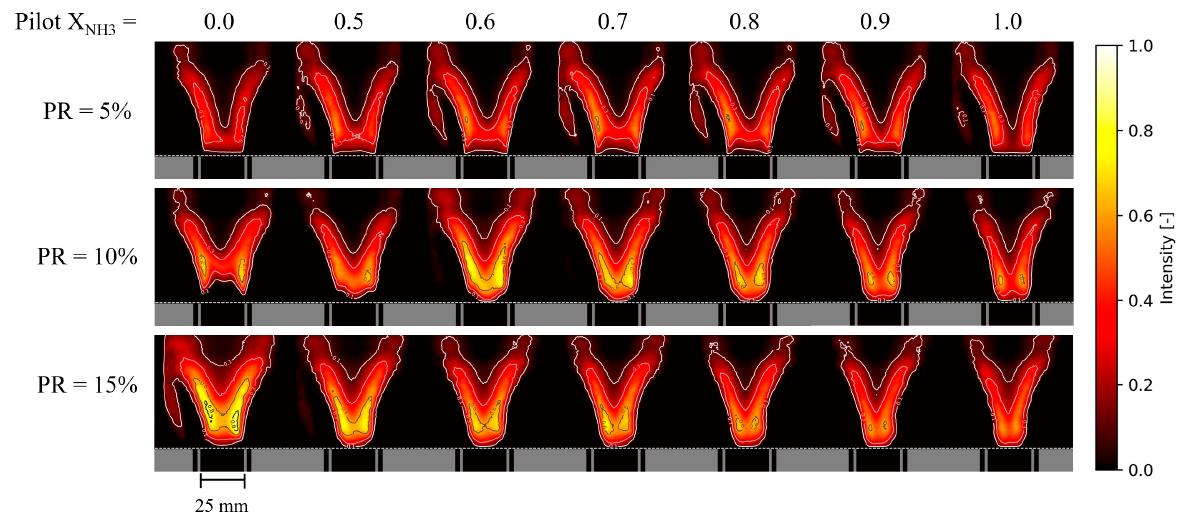
Figure 12. Normalized 2-D distributions of time-averaged OH intensity for NH 3 –CH 4 –air flames as a function of the pilot NH 3 fraction for PR = 5 ( top ), 10 ( middle ), and 15% ( bottom ).